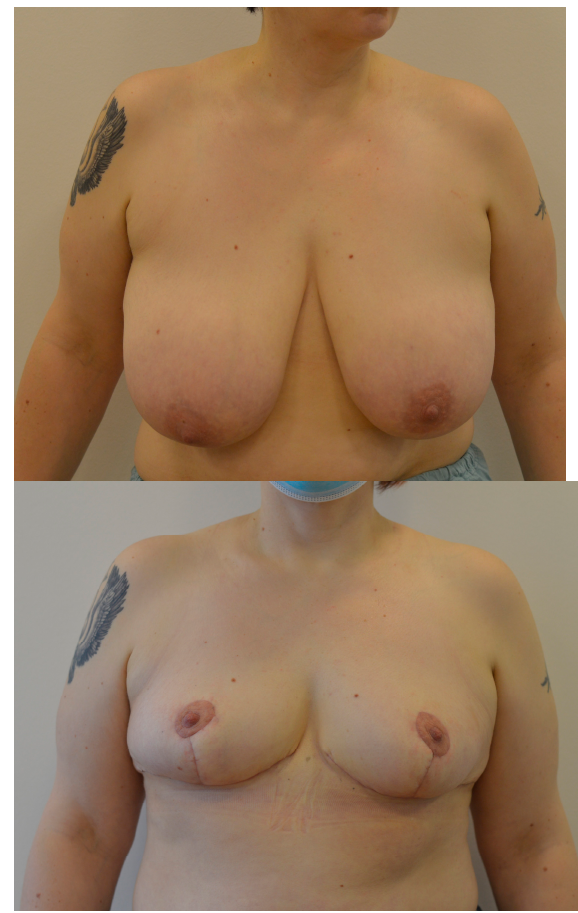
Figure 1. Example of patient, who underwent breast reduction surgery with Wise pattern incision and superomedial pedicle.